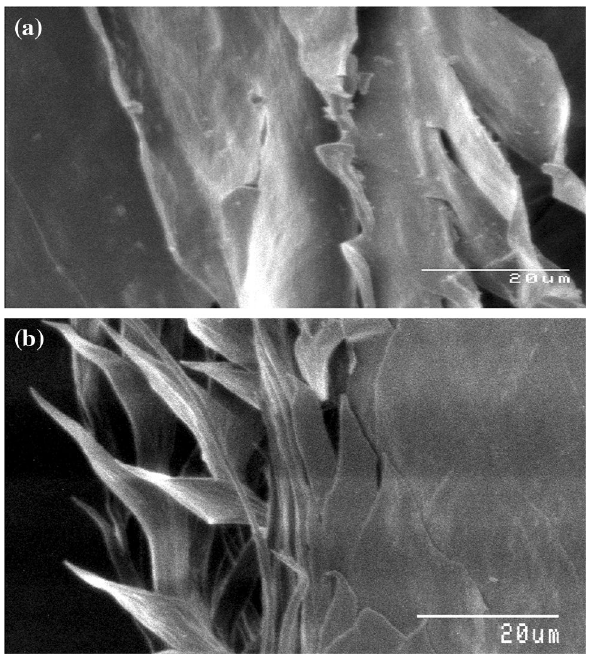
Fig. 2 a Chicken feather before 1500×. b Chicken feather after